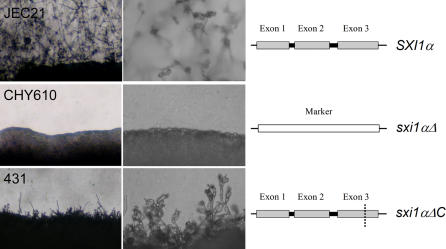
Haploid Dα Strains Bearing the SXI1Dα C-Terminal Deletion Are FertileNatural Dα isolates with the C-terminal deletion in the SXI1Dα gene mate and produce mating hyphae, basidia, and spores. From top to bottom are wild-type α reference strain JEC21, isogenic sxi1DαΔ mutant strain CHY610, and nonisogenic natural serotype D isolate 431 with the SXI1Dα C-terminal deletion, all mated with the reference a strain JEC20. Mating filaments are shown in the left images (×40), and basidia with spore chains are shown in the right images (×200). Diagrams at far right indicate the SXI1Dα allele.